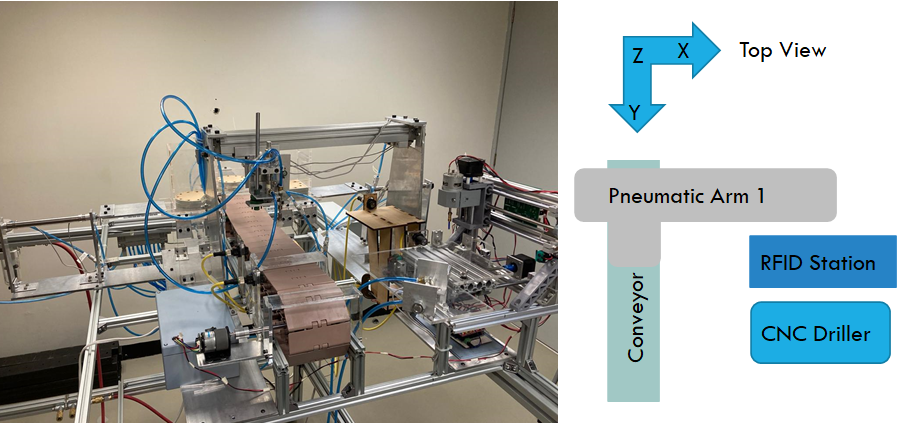
Figure 7. Small-scale manufacturing cell. The pneumatic arm has 3-DoF controlled by the same number of double-effect pneumatic actuators and a suction cup. This arm moves caps between the conveyor, the RFID station, and the CNC station (see the schematic from top view at the